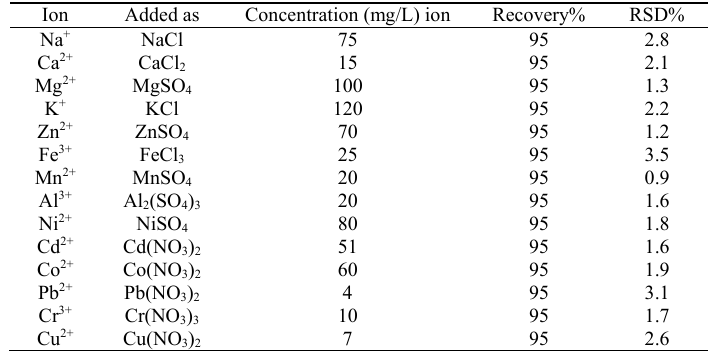
Table 1 The results of additional metal ions on the designation of 17.5 µg/mL of Hg(II) ions